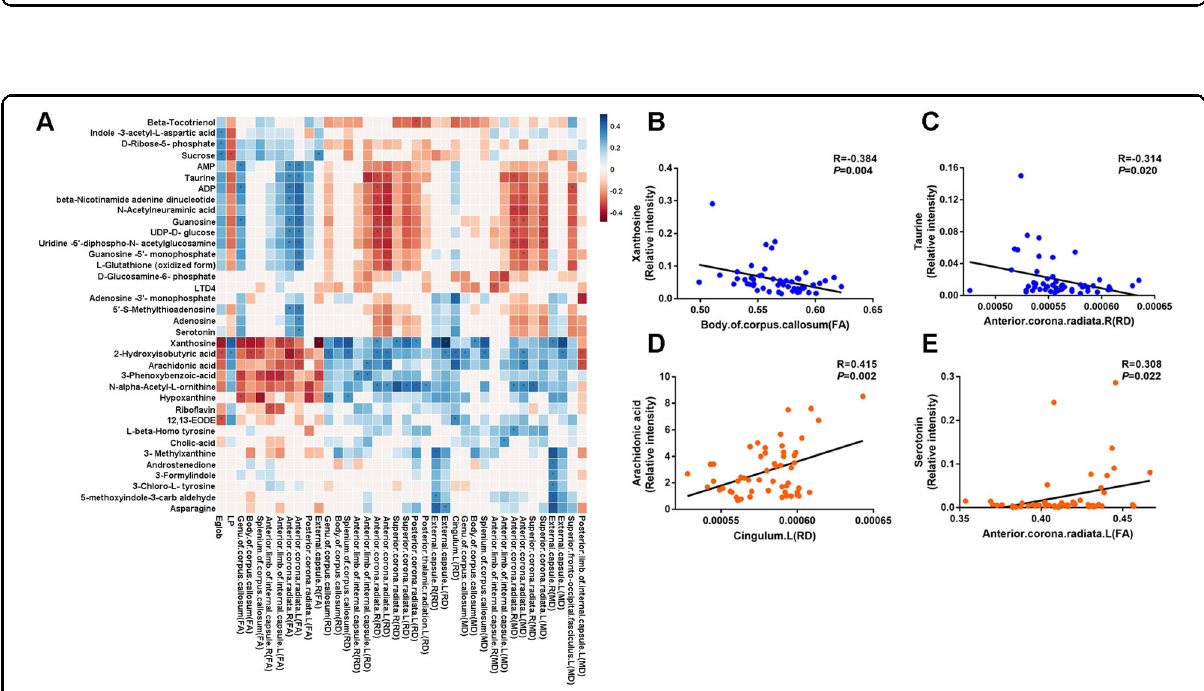
Fig. 4 Main disordered pathways of differential metabolites in recovered COVID-19 patients when compared to healthy controls 3 months after discharge. The color of red and blue for metabolites illustrated that the metabolite was increased or decreased in recovered COVID-19 patients when compared with healthy controls, respectively.